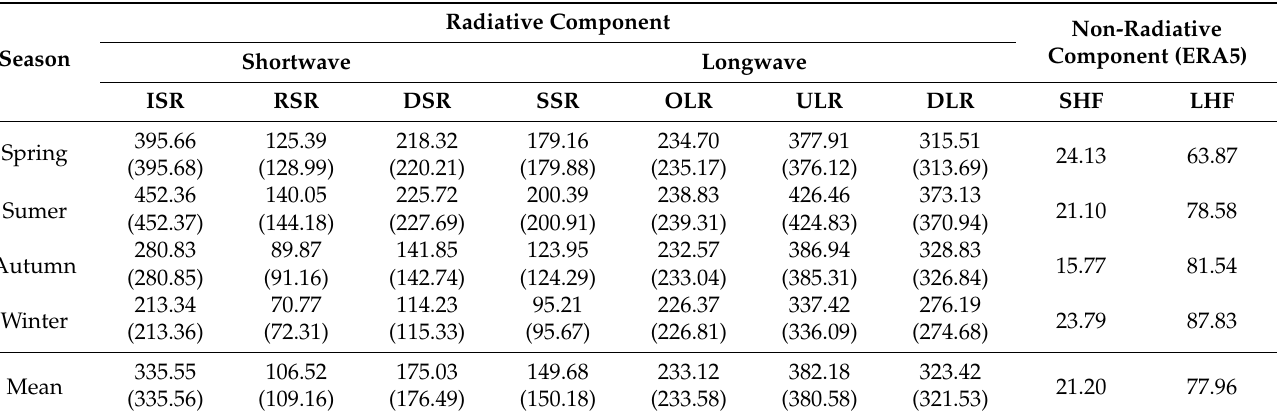
Table 3. Seasonal mean values for radiative components by GK2A/AMI (the values in parentheses are by CERES EBAF) and non-radiative components by ERA5 in research area, during 2021. Radiative Component Season